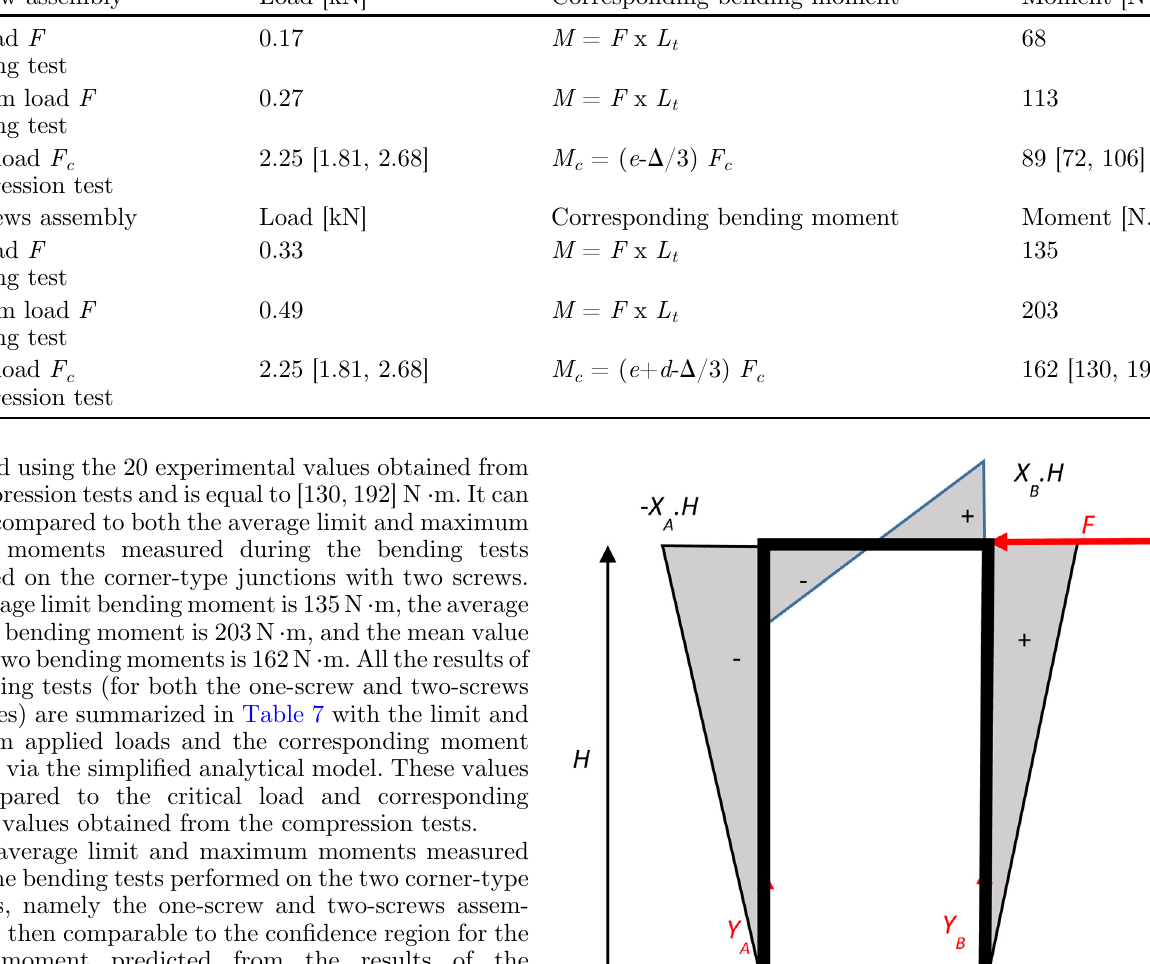
Table 7. Comparison between the bending test results and the predictions of the analytical model obtained from the critical load F c of the compression test for the one-screw assembly (top) and the two-screws assembly (bottom). One-screw assembly